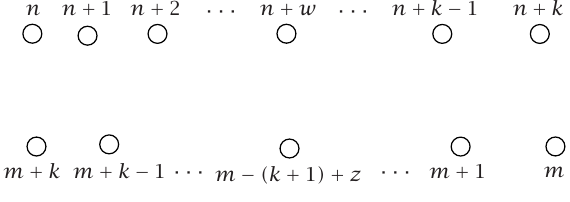
Figure A.2 . Arrangement of vertex labels in the